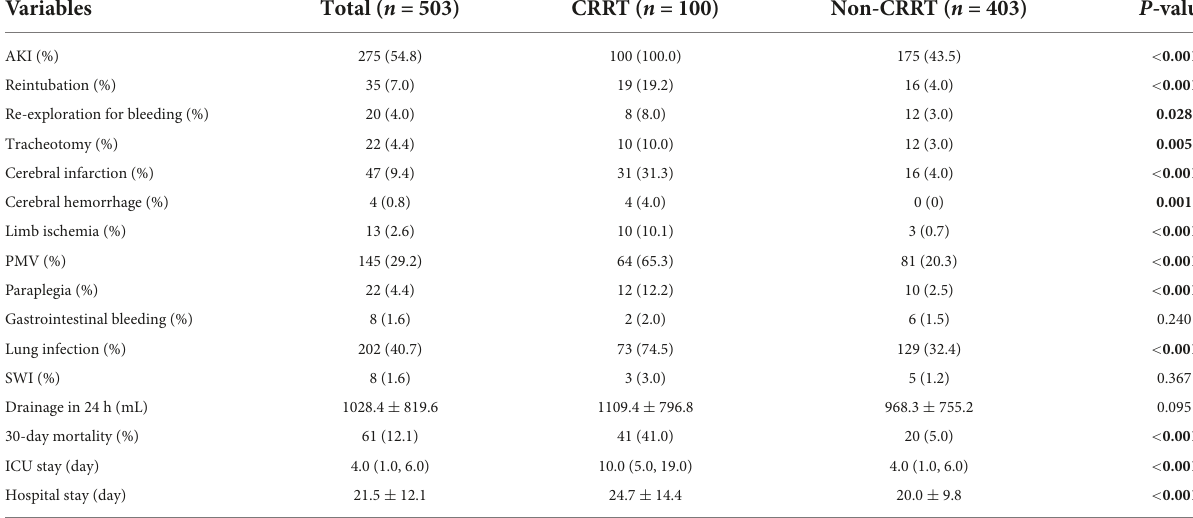
TABLE 4 Comparison of postoperative variables.